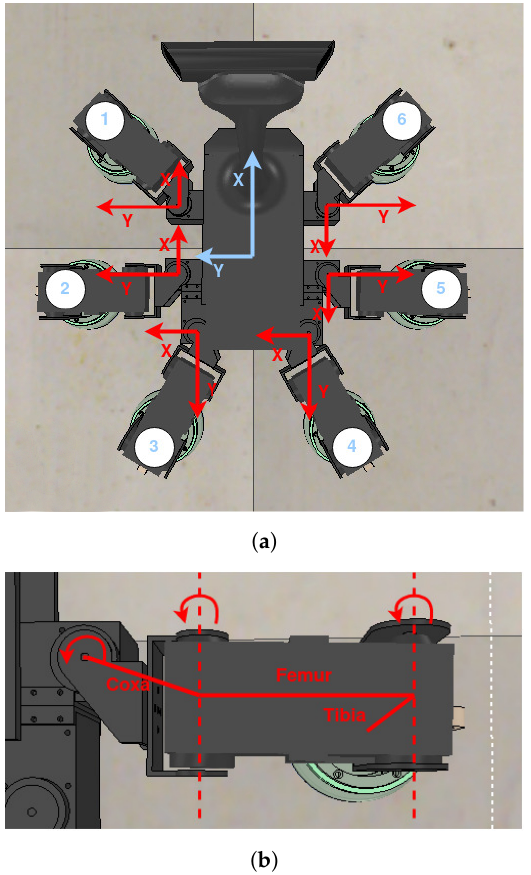
Figure 1. Joint axis and reference systems of the legs. ( a ) ROMHEX with the reference system of the body and legs, and leg identifier. ( b ) Axis of ROMHEX